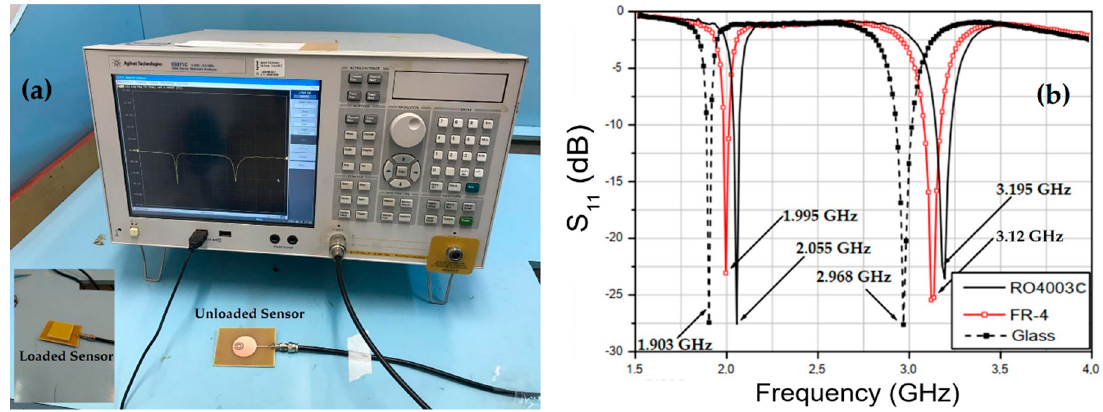
Figure 6. Experimental setup and results for the proposed sensor: ( a ) Measurement setup; ( b ) measured results for FR-4, glass, and Rogers RO4003C.